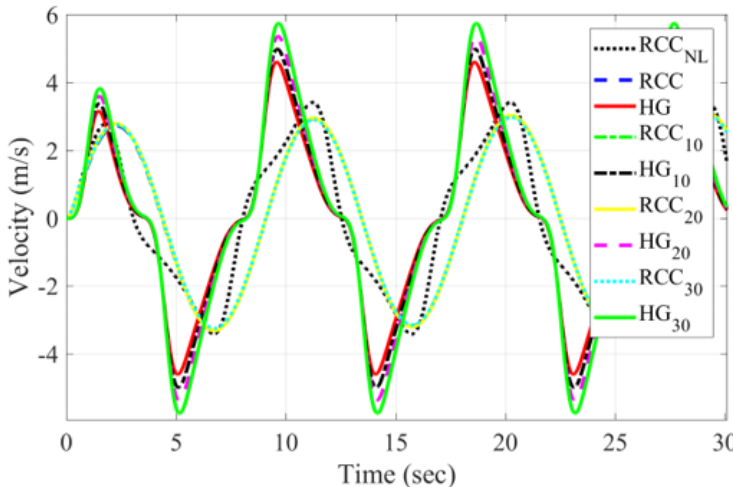
Figure 17. Buoy velocities for the first 30 s of 100 s duration for all cases, respectively.